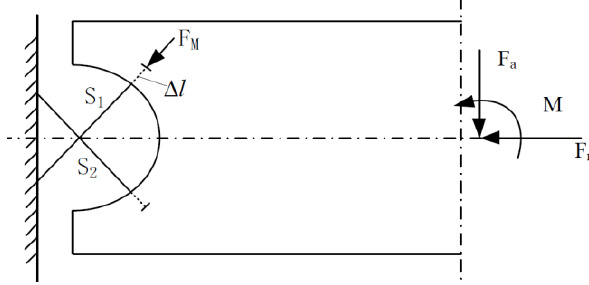
Figure 12: A schematic view of the inner ring under negative clear-